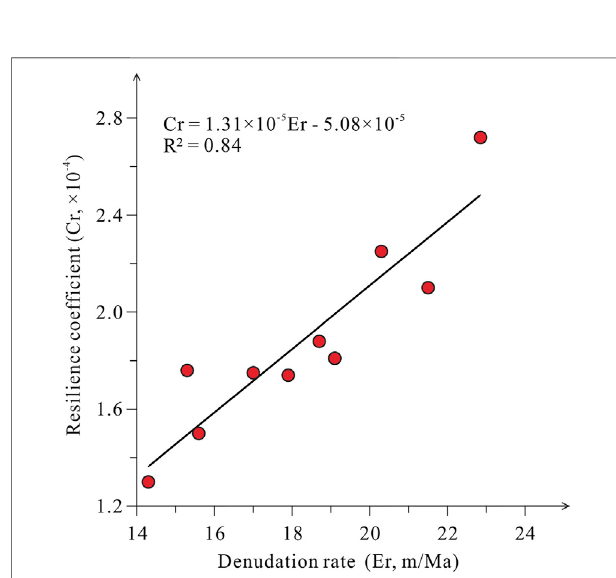
FIGURE 5 | (A) Variation of porosity with effective stress and (B) resilience coef fi cients during unloading of Chang 7 shale samples in the adjacent area of the Longdong area.